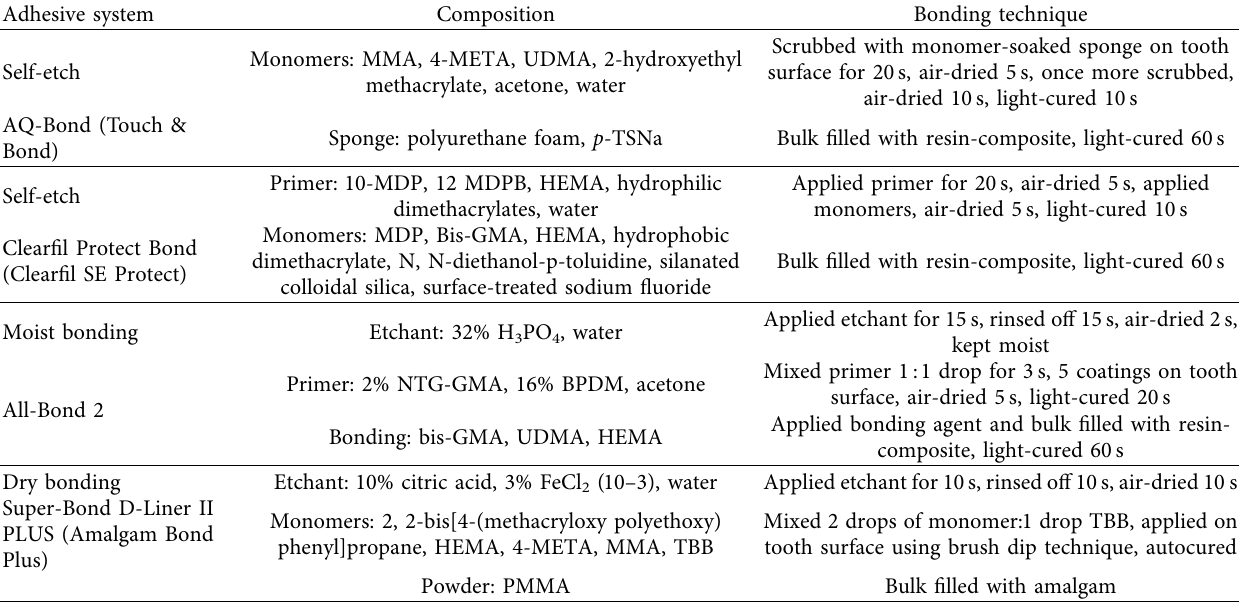
Table 1: The composition and bonding technique of adhesive